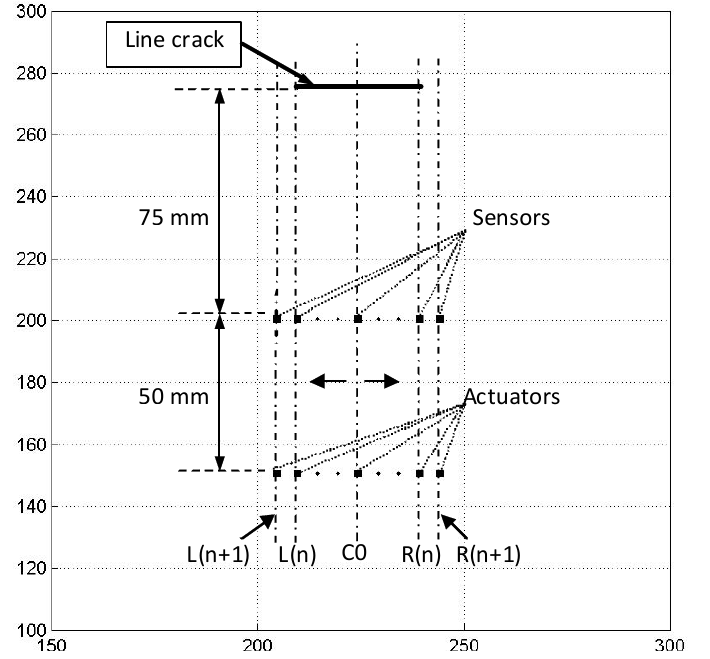
Figure 9. Quantification of damage extent (adopted from Figure 9 in